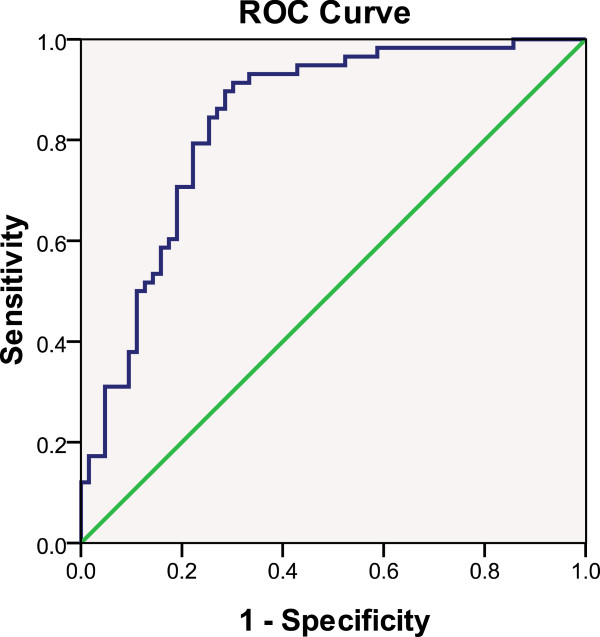
Figure3Area under ROC curve of the predicted probability of IgAN with “FIB + sIgA + Manifestation” combination from logistic regression. Area under the ROC curve for predicting immunoglobulin A nephropathy (IgAN) with the equation derived via logistic regression analysis, which includes the “fibrinogen (FIB) + serum immunoglobulin A level (sIgA) + manifestation” combination. The state variable is IgAN.